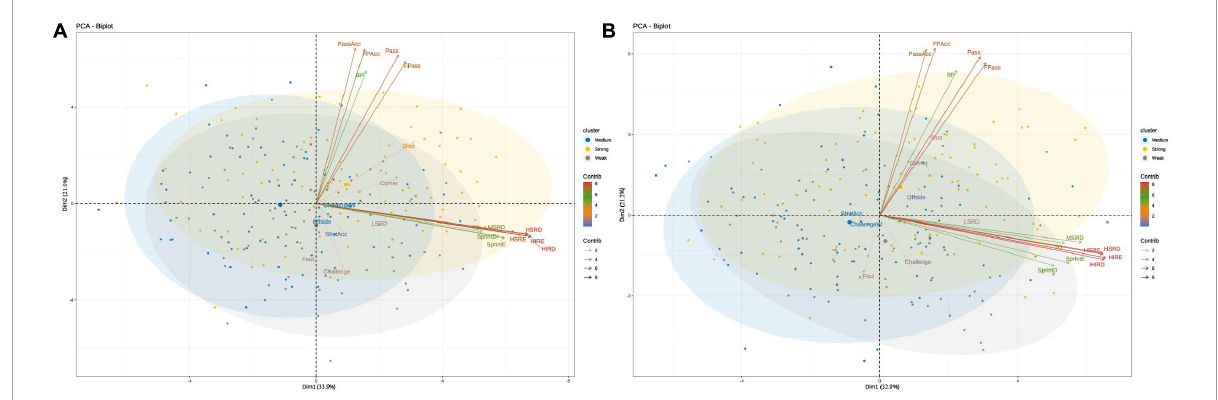
FIGURE1 Principal component analysis (PCA) biplot of individuals and explanatory variables at home (A) and away matches (B) . The biplot shows the PCA scores of the explanatory variables as vectors and individuals among the three levels of teams in a two-dimensional space. Individuals on the same side as a given variable should be interpreted as having a high contribution on it. The magnitude of the vectors (lines) shows the strength of their contribution to each PC. The angle between the lines approximates the correlation between the explanatory variables they represent. The closer the angle is to 90, or 270 degrees, the smaller the correlation while An angle of 0 or 180 degrees reflects a correlation of 1 or –1, respectively. Colored concentration ellipses (size determined by a 0.95-probability level) show the observations grouped by mark class. TD, Total Distance; SprintD, Sprint Distance; SprintE, Sprint Efforts; HSRD, High-speed running distance; HSRE, High-speed running efforts; HIRD, High-intensity running distance; HIRE, High-intensity running efforts; MSRD, Moderate-speed running distance; LSRD, Low-speed running